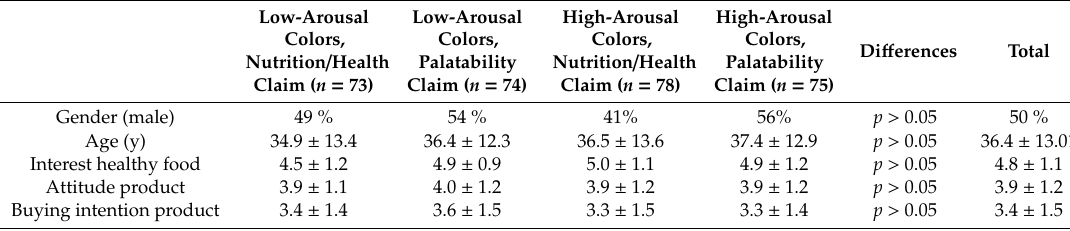
Table 1. Variables measured by condition (mean and standard